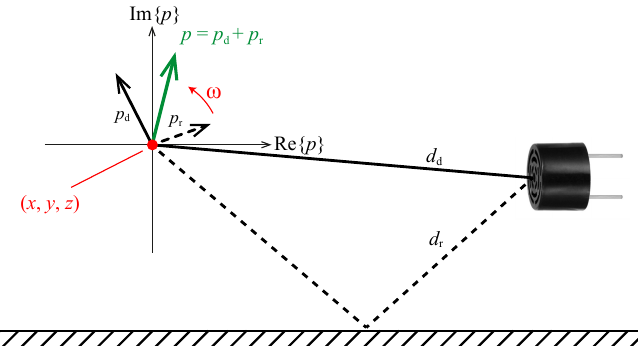
Figure 4. Direct (solid line) and reflected (dashed line) pressure components generated by a single transducer that are superimposed depending on the position and orientation of the transducer relative to the reflecting surface. The total pressure generated by the transducer is shown in